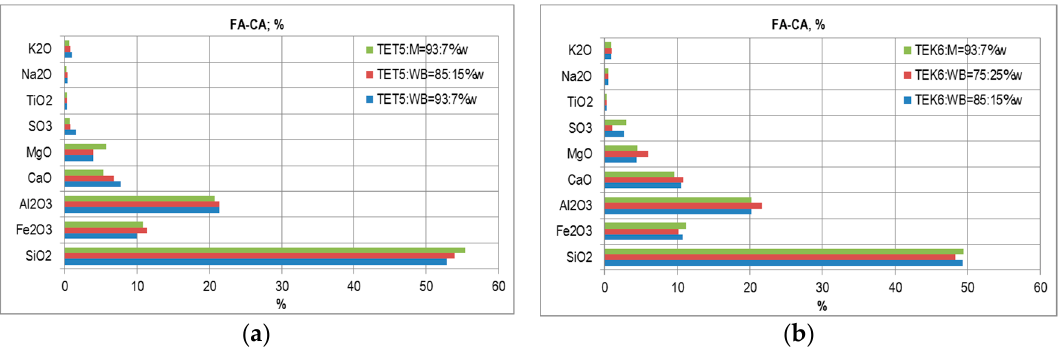
Figure 3. Fly ash—chemical analysis (FA ‐ CA) for selected co ‐ firing regimes ( a ) biomass co ‐ firing with lignite TET5, ( b ) biomass co ‐ firing with brown coal TEK6.